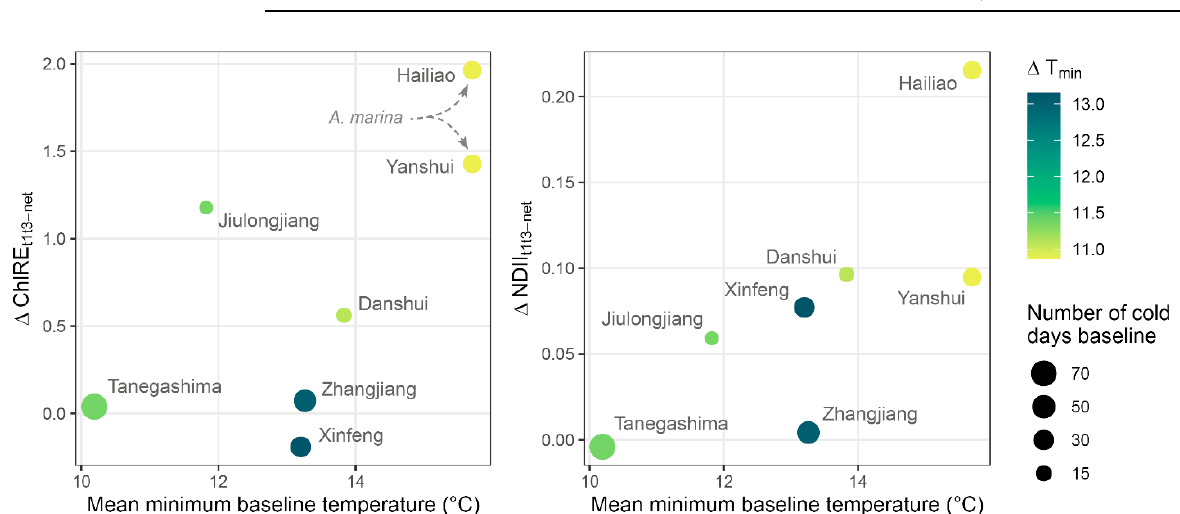
Figure 4. Mean change in chlorophyll red-edge index ( ∆ ChlRE t1t3 − net ) and normalized difference infrared index ( ∆ NDII t1t3 − net ) in seven East Asian mangrove stands a month after the 2021 cold wave event relative to the 2015–2020 baseline temperature in relation to mean minimum baseline temperature (i.e., 2015–2020) for the temporal period of the 2021 cold spell. The difference between the minimum temperature of 2021 cold event and the mean temperature of the same date range in 2015–2020 (i.e., ∆ T min ) is shown by point color, and point size indicates the total number of cold days that occurred during the winters of the baseline period (2015–2020). All sites are dominated by K. obovata except Hailiao and Yanshui where A. marina is dominant (indicated in the first panel).